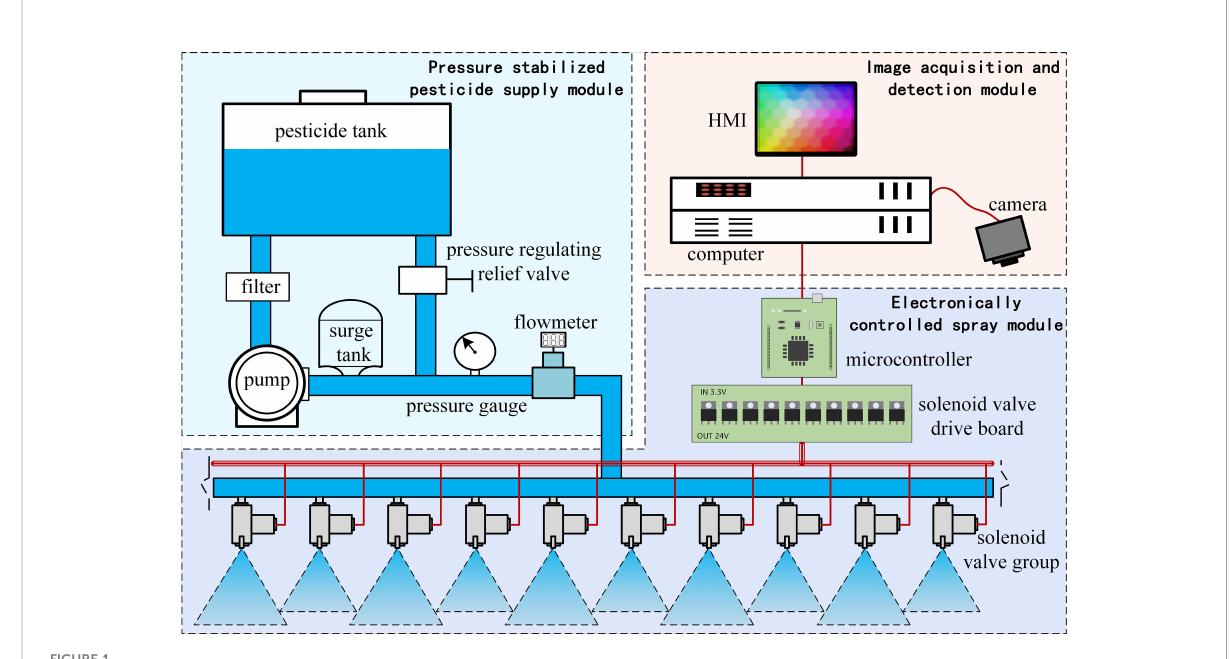
FIGURE 1 The components of the real-time target spaying